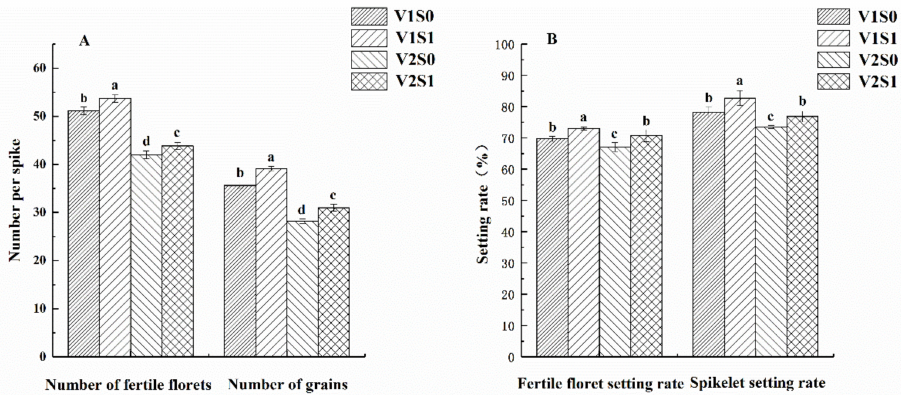
Figure 2. Di ff erences of fertile floret grain setting characteristics under exogenous 6-BA treatment and the control in wheat. Di ff erent lowercase letters above the column for the same item of the abscissa axis indicate significant di ff erences ( p < 0.05). The e ff ects of 6-BA on the number of fertile florets and grains